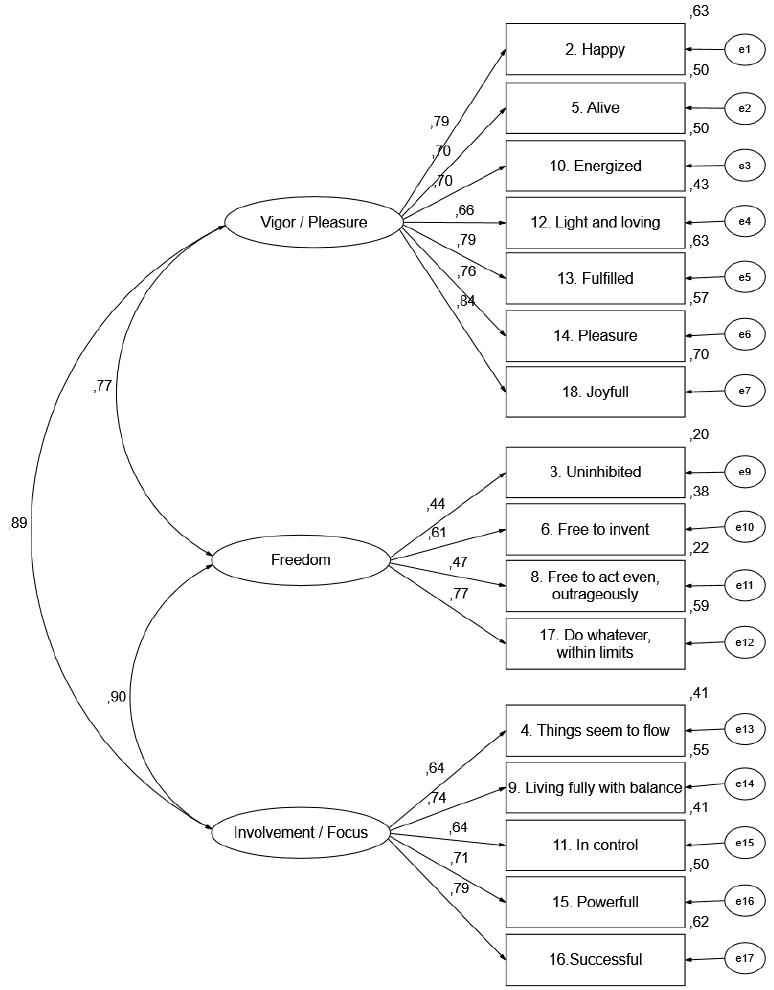
Figure 1. CFA re-specified of the 3-first-order factors of the SAI-Rp.